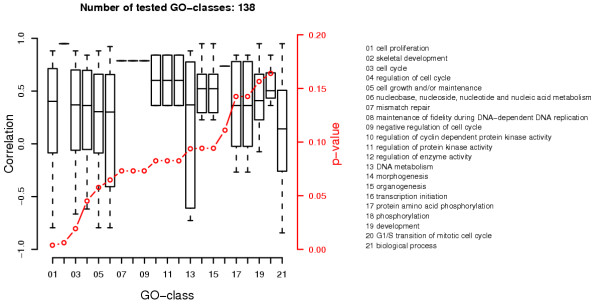
Correlations and p-values of the expression dataset from Chi. The diagram contains the contains the box-and-whisker plots and the p-values of the twenty GO-classes that yield the most significant results for the respective dataset and of the GO-class biological process. It shows for different GO-classes, how strongly the expression levels of genes that encode interacting proteins from this common GO-class are correlated. The GO-classes along the x-axis are ordered by the corresponding p-value. This p-value gives the probability to get the depicted correlation results using random interacting protein pairs from the respective GO-class. For comparison the GO-class 'biological process', which comprises all interaction pairs (except the self-interactions), has been added.